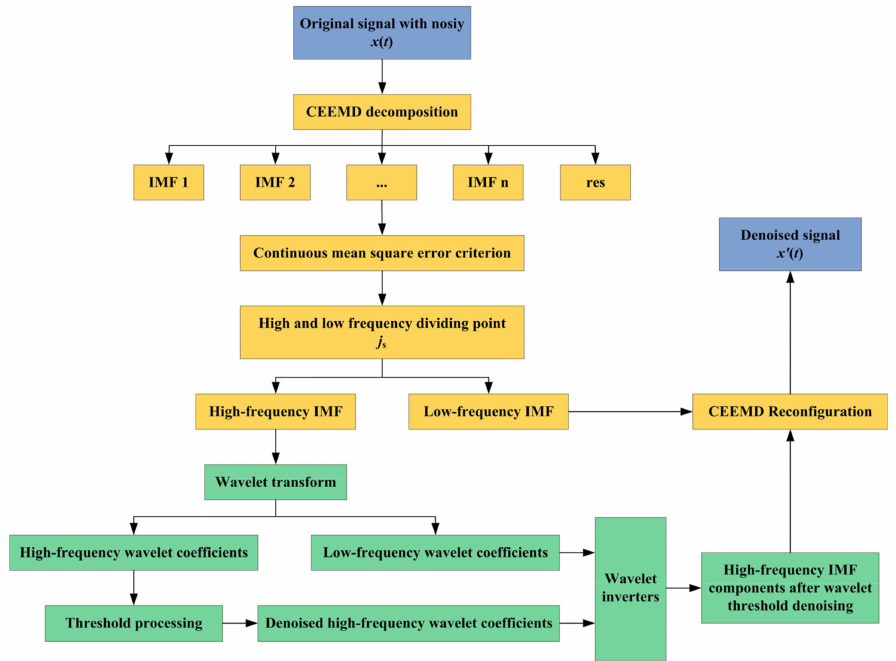
Figure 5. Impact-type sunflower yield sensor signal denoising flow chart combining CEEMD and